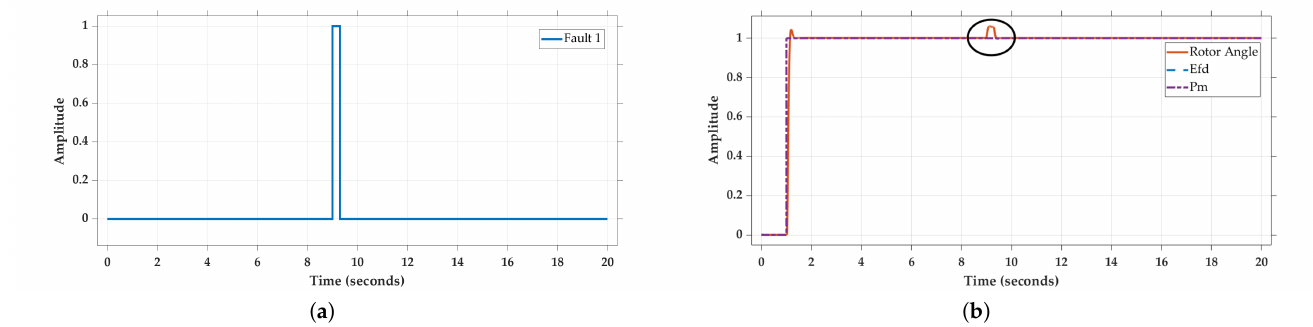
Figure 8. Synchronous generator subjected to fault at t = 9 s. ( a ) Fault characteristics; ( b ) rotor angle when E FD = 1, P m = 1, learning rate = 10, and fault at t = 9 s. Case Study 6 . Two added faults at t = 3 s and t = 9 s for a duration of ~100 ms and ~300 ms,